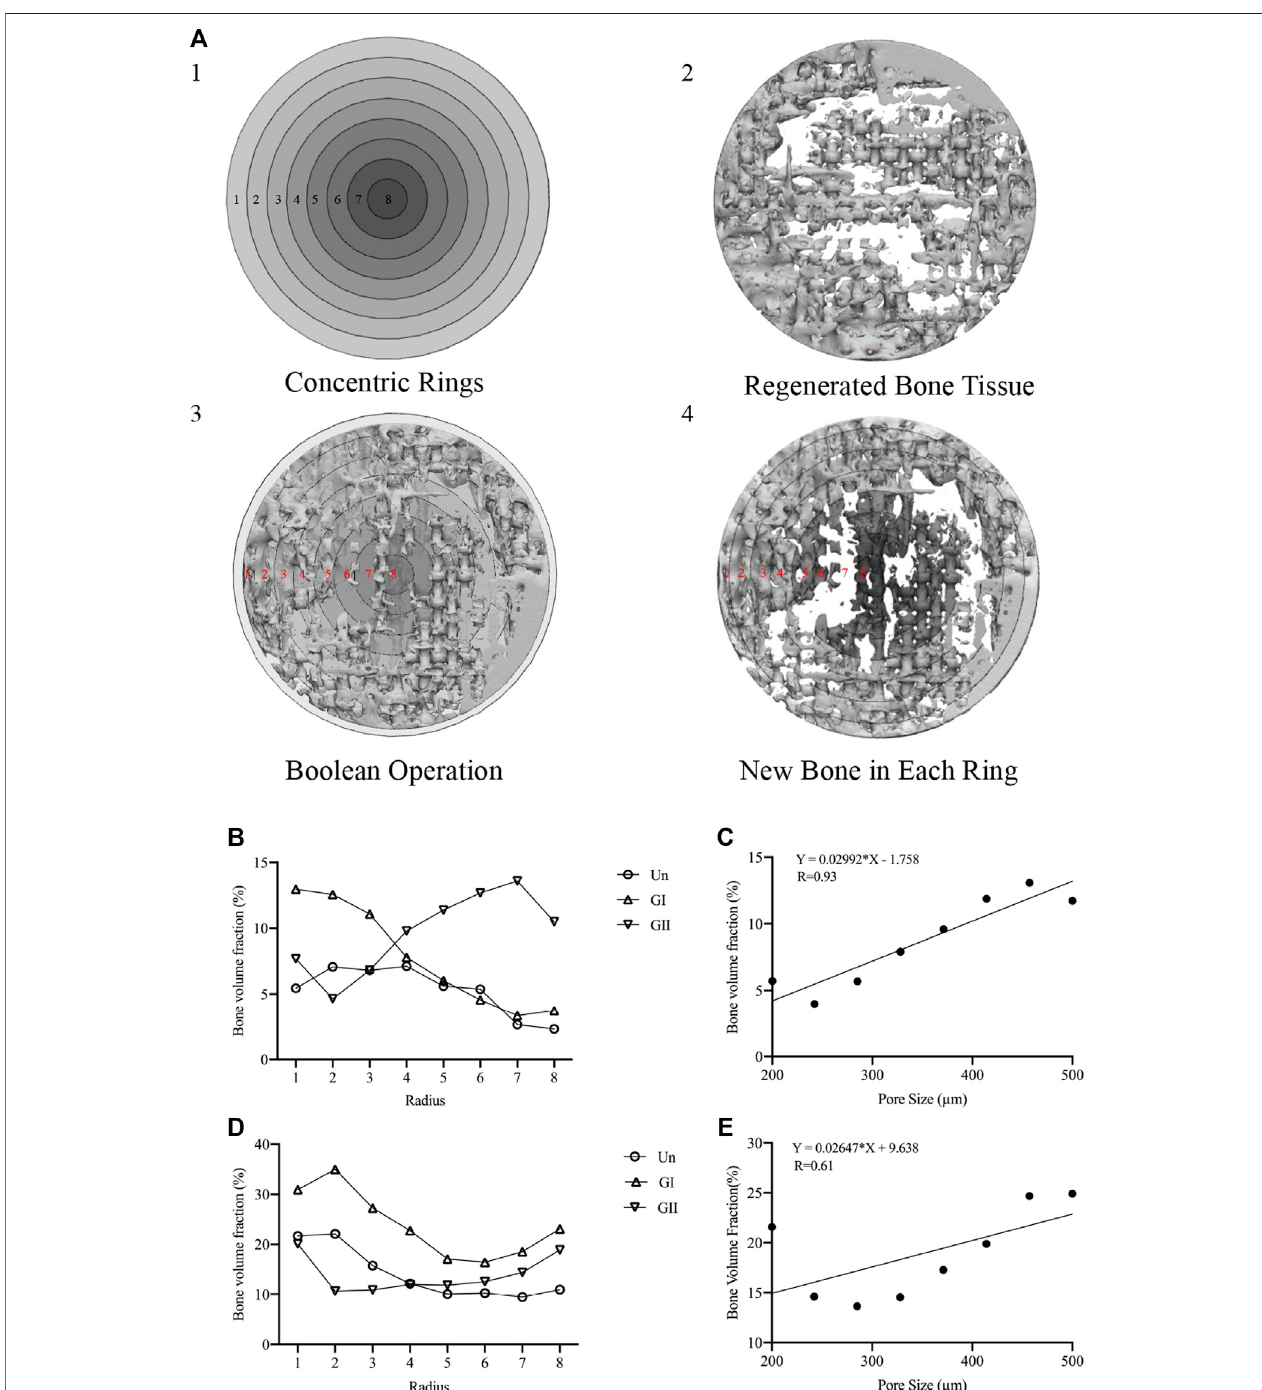
FIGURE7| Concentricringsanalysis. (A-1) Concentricringsdesignedby3-Maticsoftware. (A-2) regeneratedboneinSTLformat. (A-3) BooleanoperationsofA1 and A2. (A-4) New bone in each bone was obtained. (B) New bone of the 8 rings of in rats. (C) Linear regression plots to depict the relationship between pore size and new bone volume in rats. (D) New bone of the 8 rings of in rabbits. (E) Linear regression plots to depict the relationship between pore size and new bone volume in rabbits.